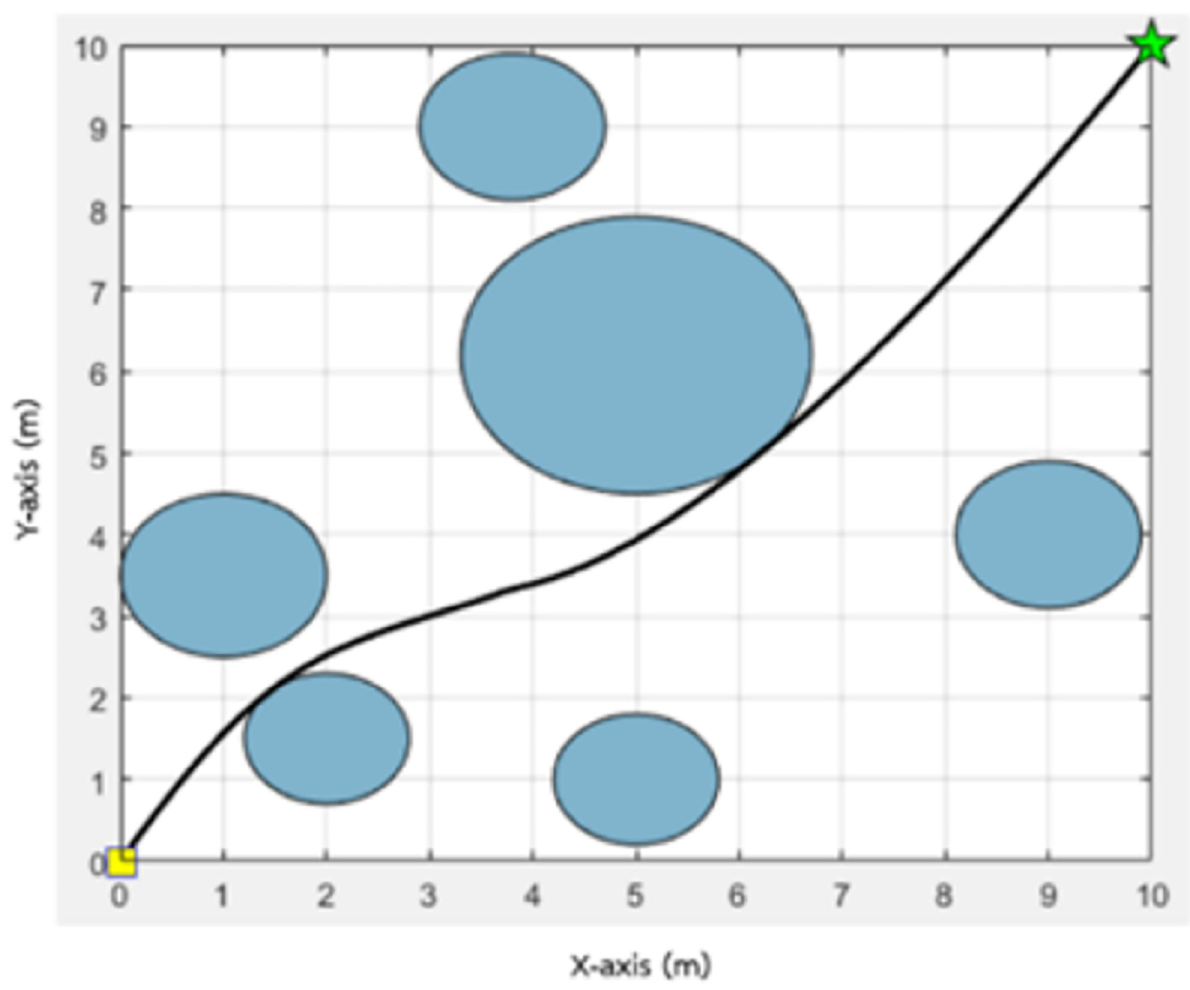
Fig 31. The path obtained from the MOEPSO algorithm in a static environment (6